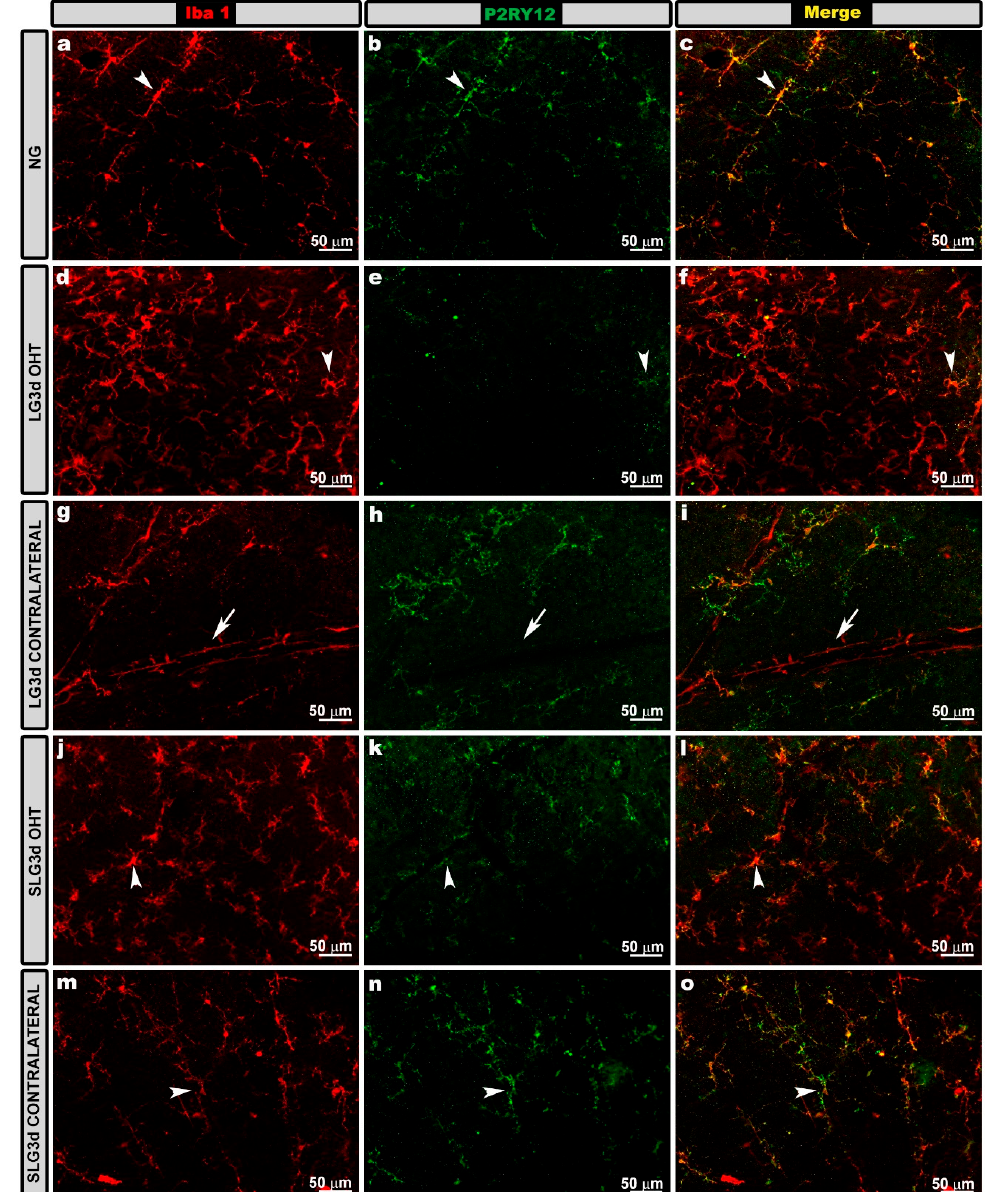
Figure 10. P2RY12 expression in the nerve fiber—ganglion cell layer (NFL-GCL) in eyes untreated and treated with saffron extract at day 3 after ocular hypertension (OHT) induction. Retinal whole mounts with double immunostaining against Iba-1 ( a , d , g , j , m ) and P2RY12 ( b , e , h , k , n ), as well as the merged ( c , f , i , l , o ). Iba-1 + cells showed P2RY12 expression (arrowhead), except perivascular iba-1 + cells ( g , arrow). P2RY12 expression was down-regulated in LG3d OHT ( d – f ). SLG3d OHT eyes showed only mild down-regulation of P2RY12 expression. NG, LG3d contralateral, and SLG3d contralateral eyes showed a similar P2RY12 expression. Abbreviations: Naïve age-matched control (NG), lasered group contralateral (LG3d contralateral), lasered group ocular hypertension (LG3d OHT), lasered group contralateral + saffron (SLG3d contralateral), lasered group ocular hypertension + saffron (SLG3d OHT).